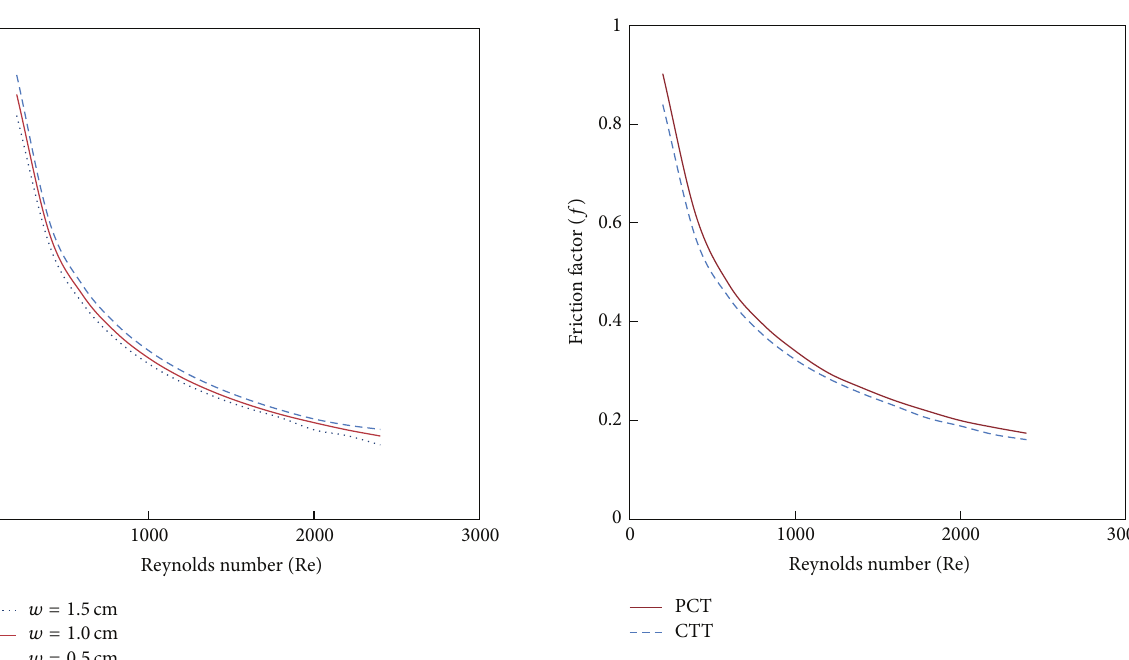
Figure 12: The effect of twist configuration with 4% CuO nanofluid on friction